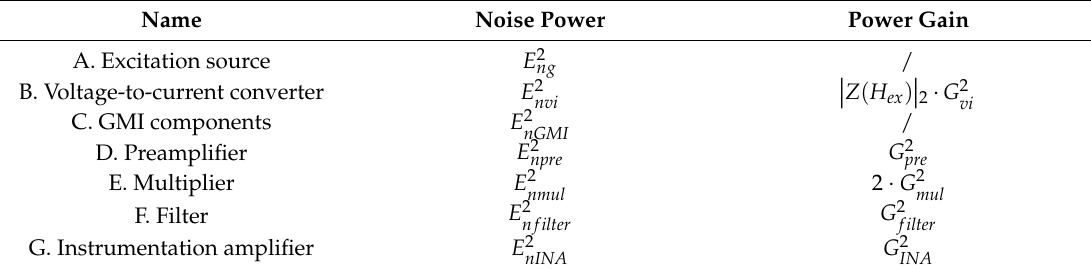
Table 1. Internal noise and power gain description for each